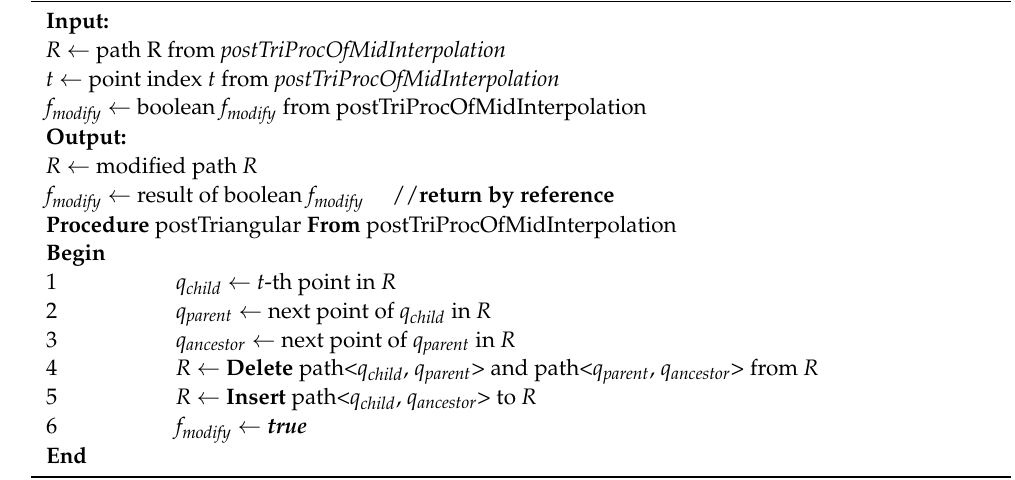
Algorithm 4 Pseudocode of Proposed Post Triangular Function